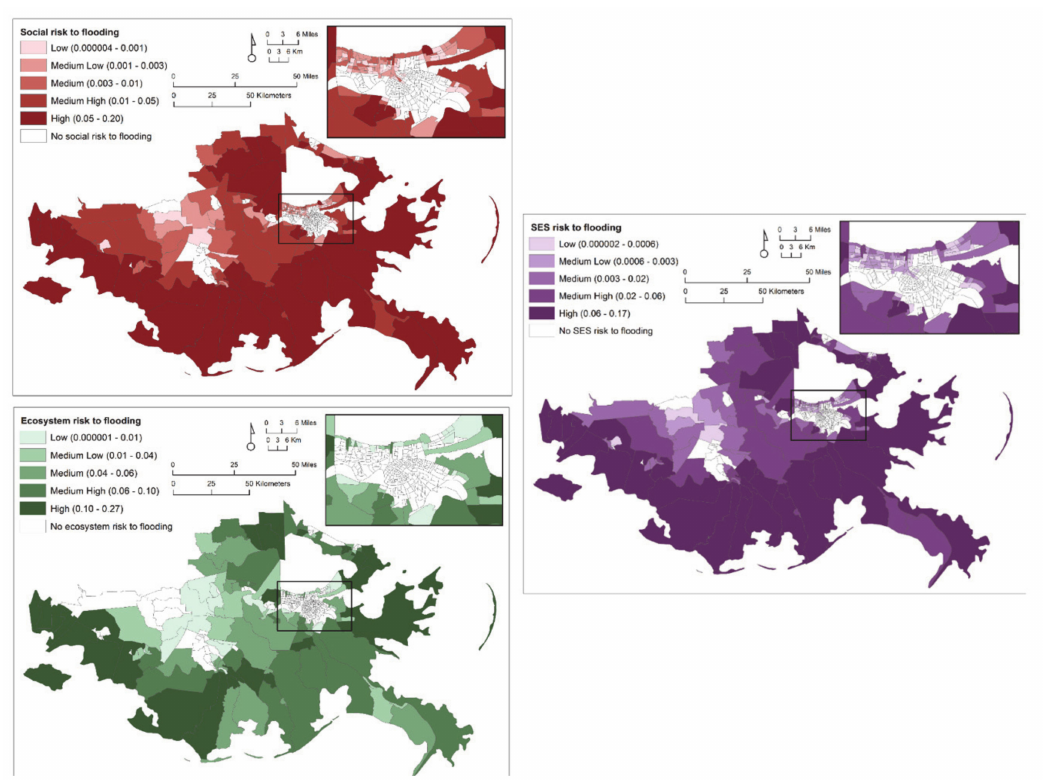
Figure 5. Social (top left) and ecosystem (bottom left) risk to coastal flooding (storm surge) in the delta. Averaging these scores yields SES flood risk scores (right). Flood data is from CPRA (2017) [34] and census tract data from (US Census, 2016)